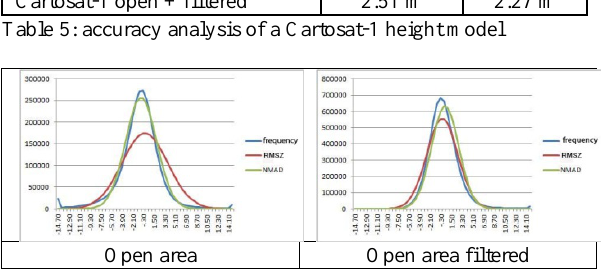
Figure 5: Frequency distribution of Cartosat-1 DSM in Warsaw test area